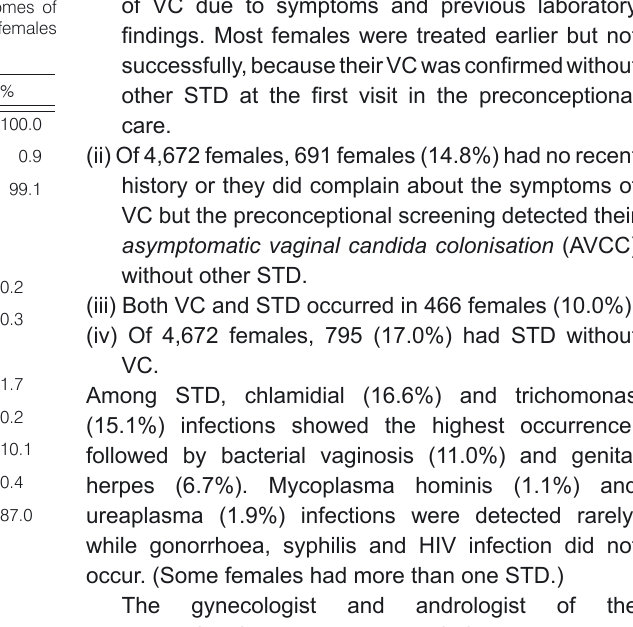
Table 2. The data set of the study, the pregnancy outcomes of female participants and the characteristics of females who delivered live-born